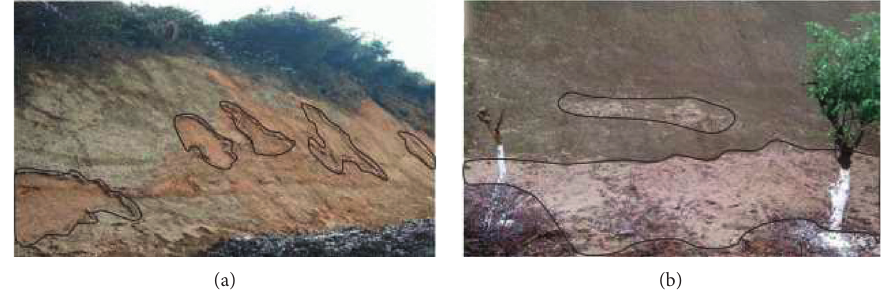
Figure 1: Spalling of the shallow surface of slopes in the intermittently frozen area. (a) Flaky exfoliation. (b) Fragmentary